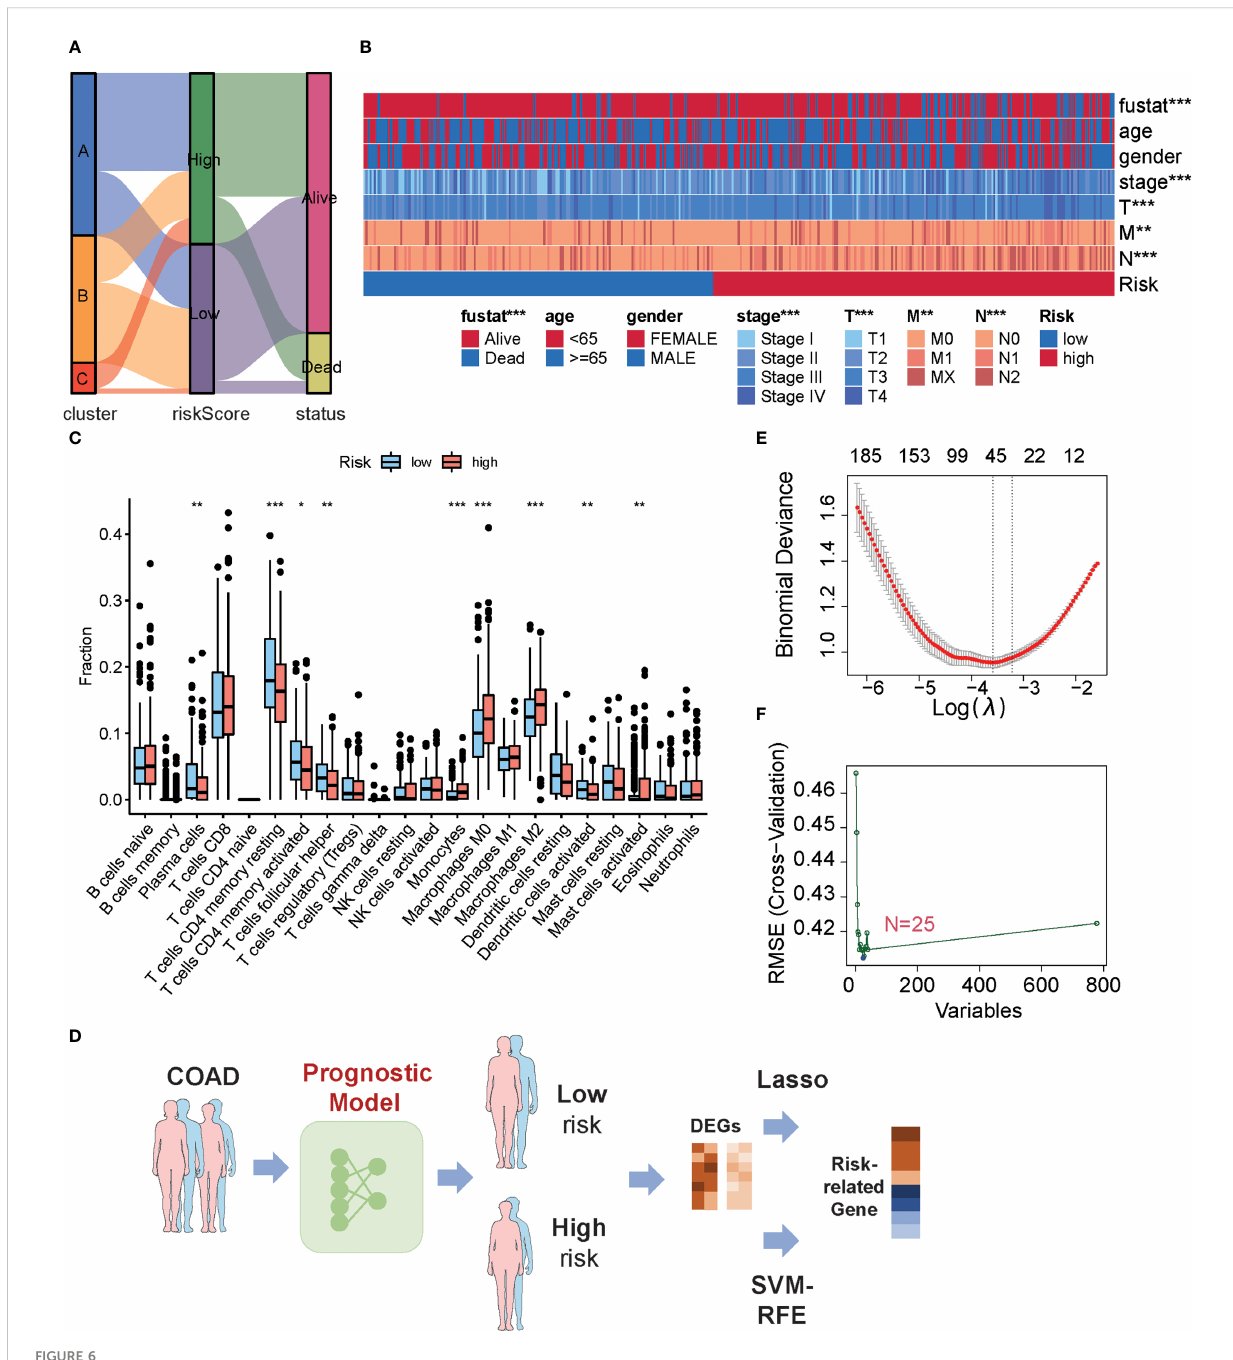
FIGURE 6 Characteristics of low- or high-risk colon cancer patients. (A) The relationship among cluster label, MKPC score, and survival state in TCGA-COAD cohort. (B) The difference of clinical features in TCGA-COAD cohort in the MKPC risk group by Chi-square test. * p < 0.05; ** p < 0.01; *** p < 0.001. (C) ssGSEA of immune cell content between different MKPC risk groups in TCGA-COAD cohort (Wilcoxon test). (D) Prognosis-related key target analysis process. (E) Feature screening based on LASSO regression. (F) Feature screening based on Random Forest regression. The blue point corresponds to the smallest RMSE